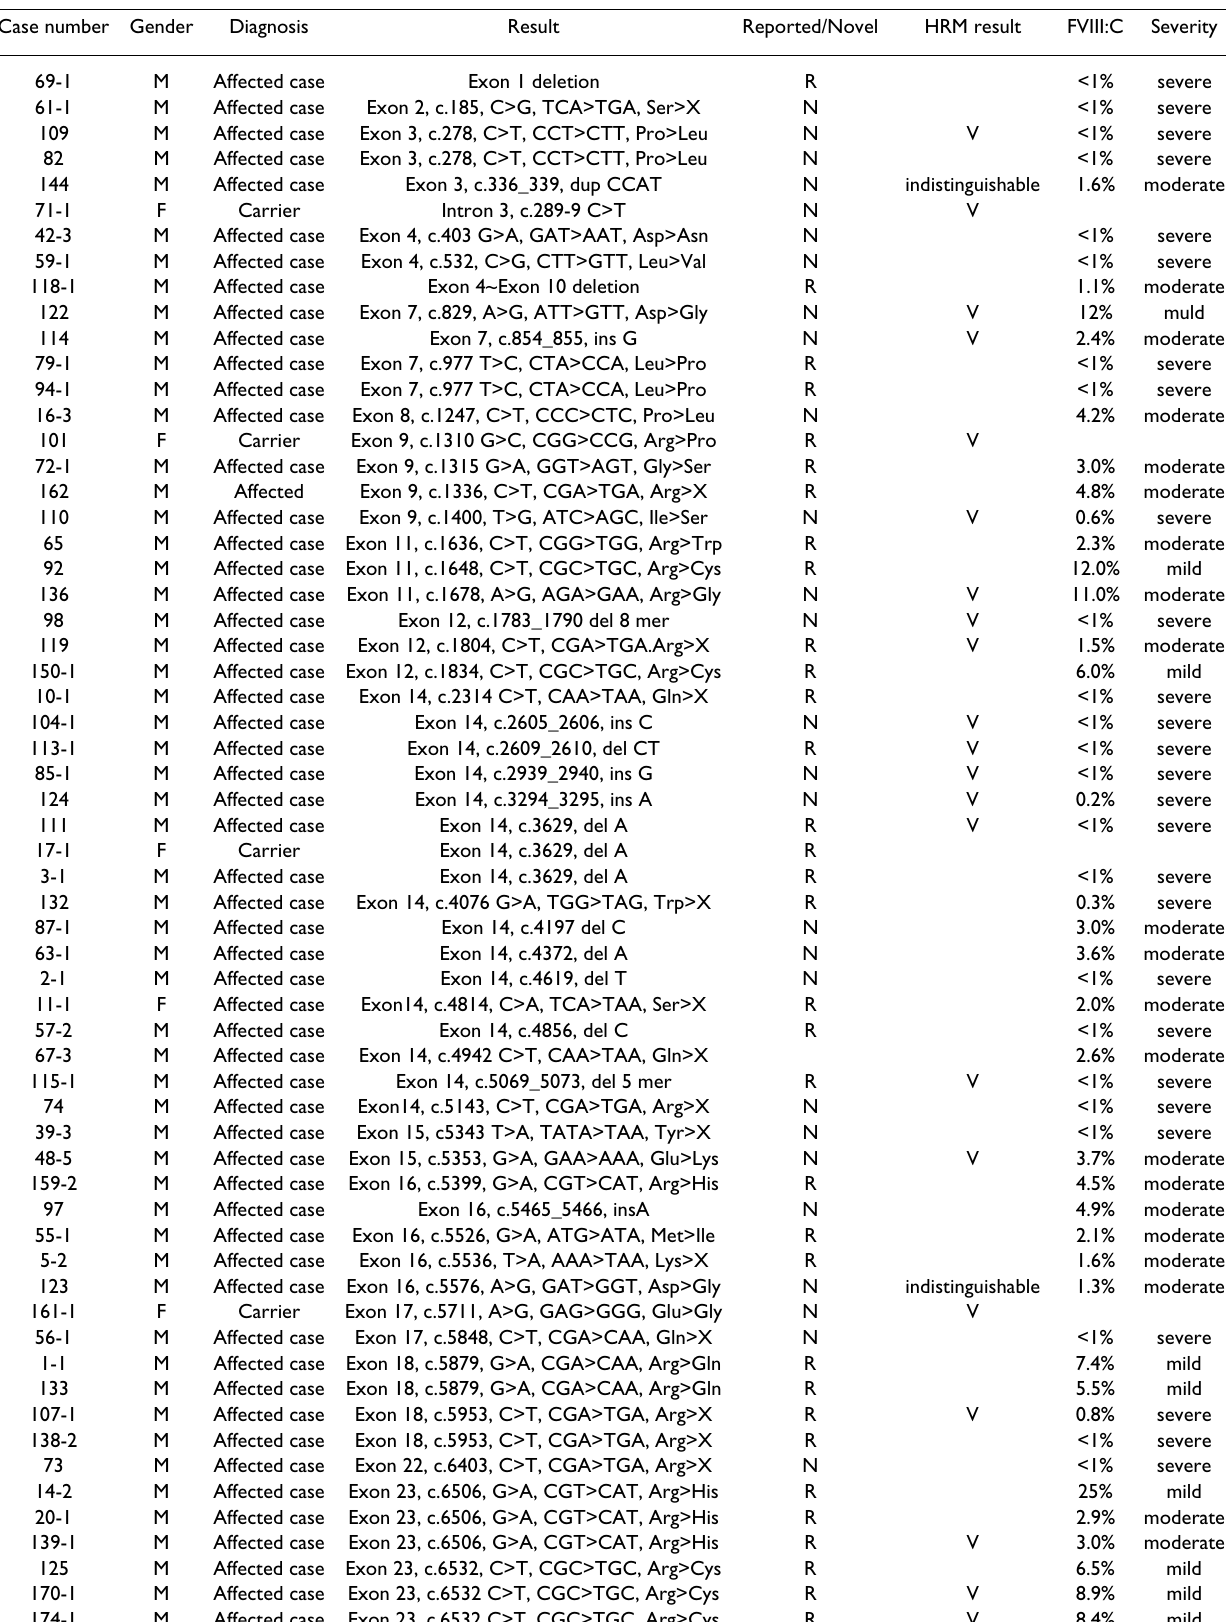
Table 3: The detailed patient